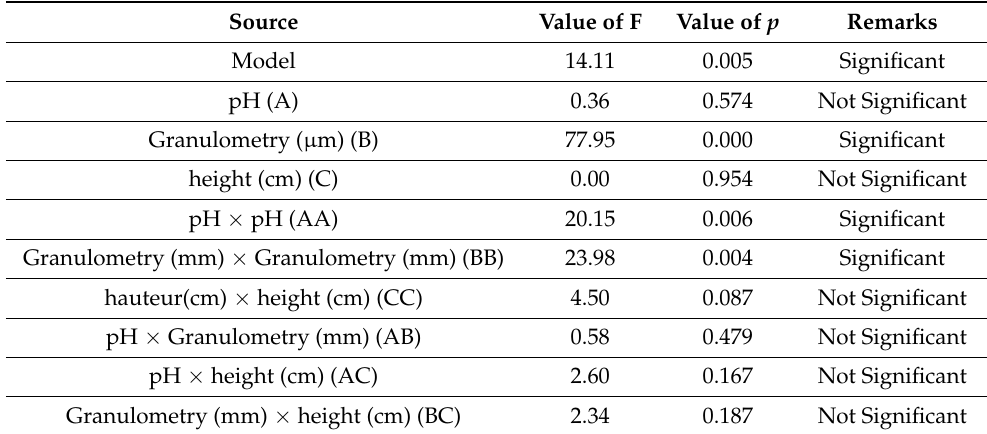
Table 4. Regression of the response surface: TA Nitrite (%) as a function of the grain size, height (cm) and pH.